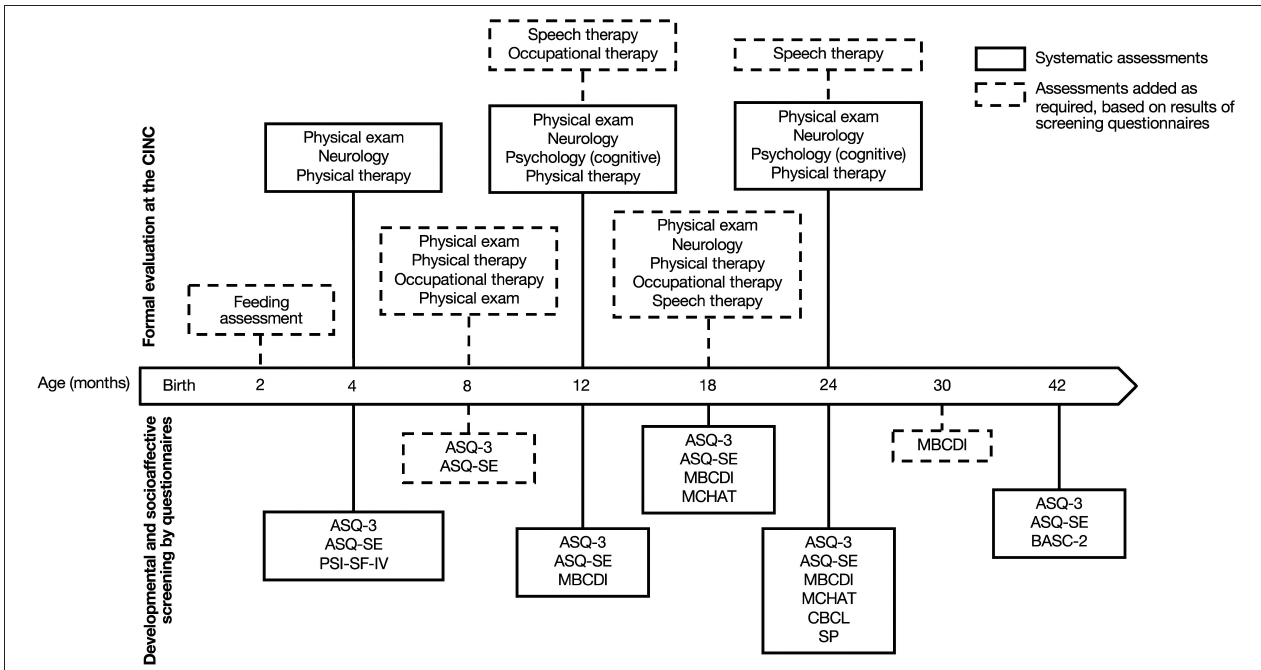
FIGURE 1 | Timeline of developmental follow-up from 4 to 42 months of age Clinique d’Investigation Neurocardiaque (CINC). Systematic screening and assessments are represented in plain lines; additional examinations based on screening are represented in dotted lines. ASQ-3, Ages and Stages Questionnaire, Third edition; ASQ-SE, Ages and Stages Questionnaire: Social–emotional; MBCDI, MacArthur–Bates Communicative Development Inventories; MCHAT, Modified Checklist for Autism in Toddlers; BASC-2, Behavioral Assessment System for Children, Second Edition; SP, Sensory profile; CBCL, Child Behavior